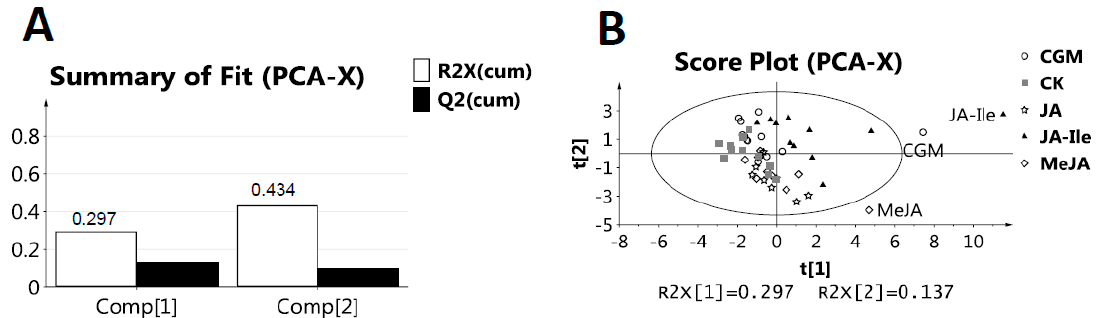
Figure 4. Principal component analysis (PCA) of metabolites in L . leucocephala leaf extracts under different elicitations. ( A ) The summary of fit of PCA score plot with two components was calculated. The first and second components accounted for 43.4 % (29.7 and 13.7 %, respectively) of the overall variance; ( B ) PCA score plot discriminated L. leucocephala extracts from JA-Ile (triangle) and control treatment (CK, box), and was disabled to distinguish between JA (star), between MeJA (diamond), between CGM (circle) and control treatment (box), respectively. There are three outliers, one from MeJA, one from JA-Ile and another one from CGM.